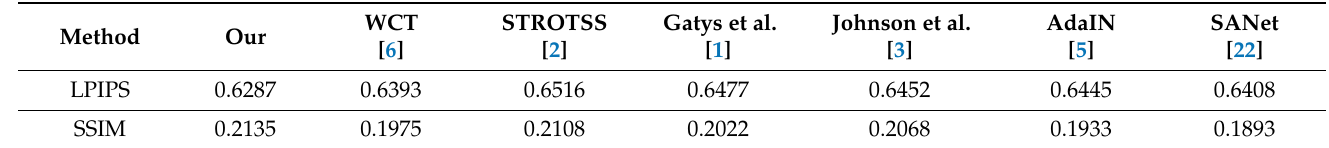
Table 3. Quantitative comparisons of LPIPS and SSIM between our method and six state-of-the-art methods.